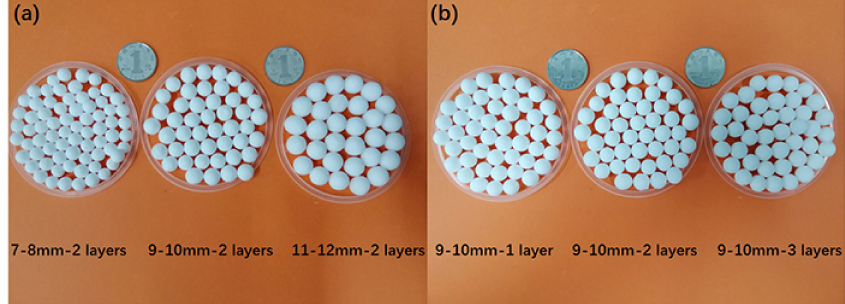
Figure 3. AR-HEMS with a different inner diameter and layer.